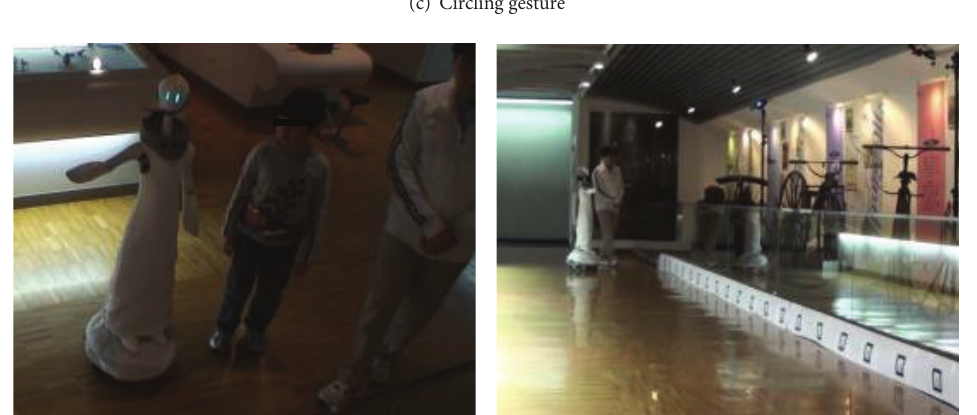
Figure 2: Robot’s gestures based on our field